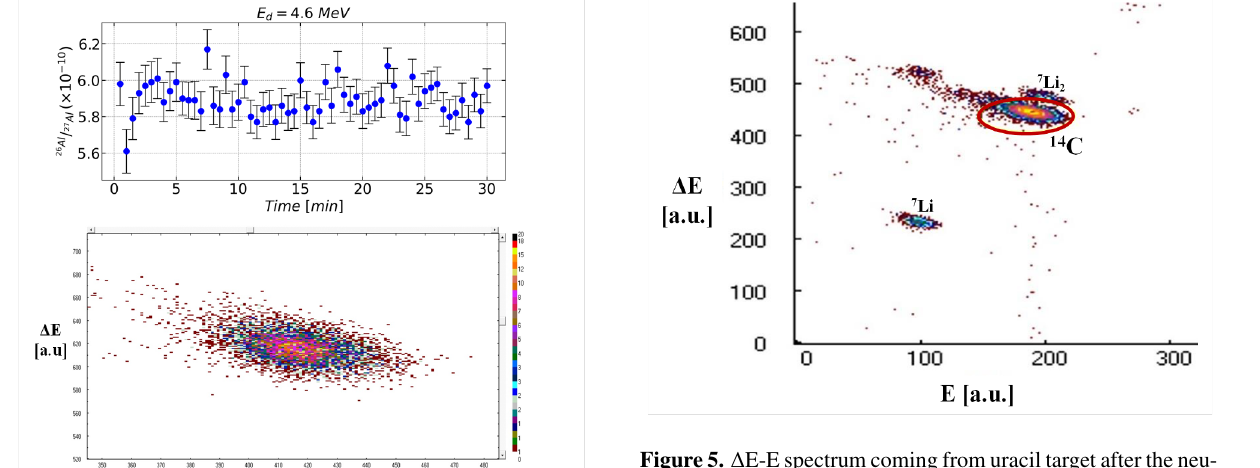
Figure 5. ∆ E-E spectrum coming from uracil target after the neu- tron irradiation to produce 14 C. Enclosed in red the 14 C events, which are well separated from 7 Li 2